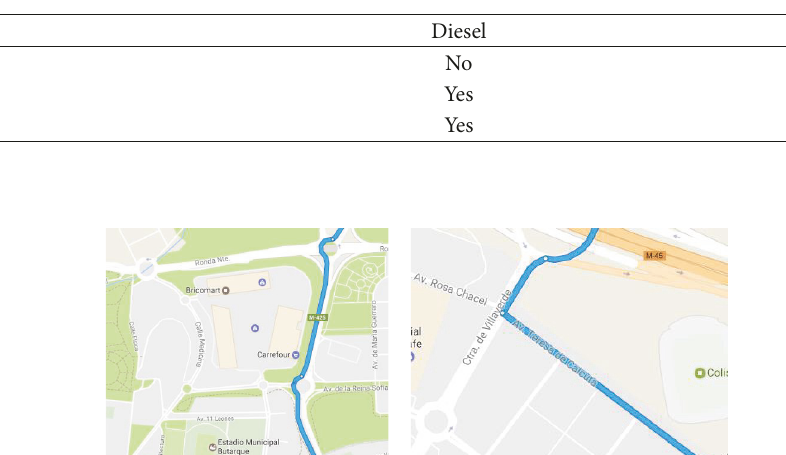
Table 1: Vehicles used for gathering data.